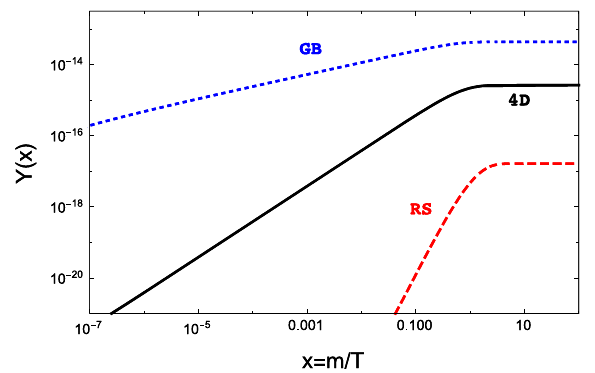
Fig. 1 Numerical solutions of the Boltzmann equation in the GB braneworld cosmology (dotted blue line), the Standard Big Bang cos- mology (solid black line), and the RS braneworld cosmology (dashed red line). Here, we set m = 10 TeV, T t = 1 TeV, m Z (cid:2) = 1 GeV, and g BL = 1 . 54 × 10 − 6